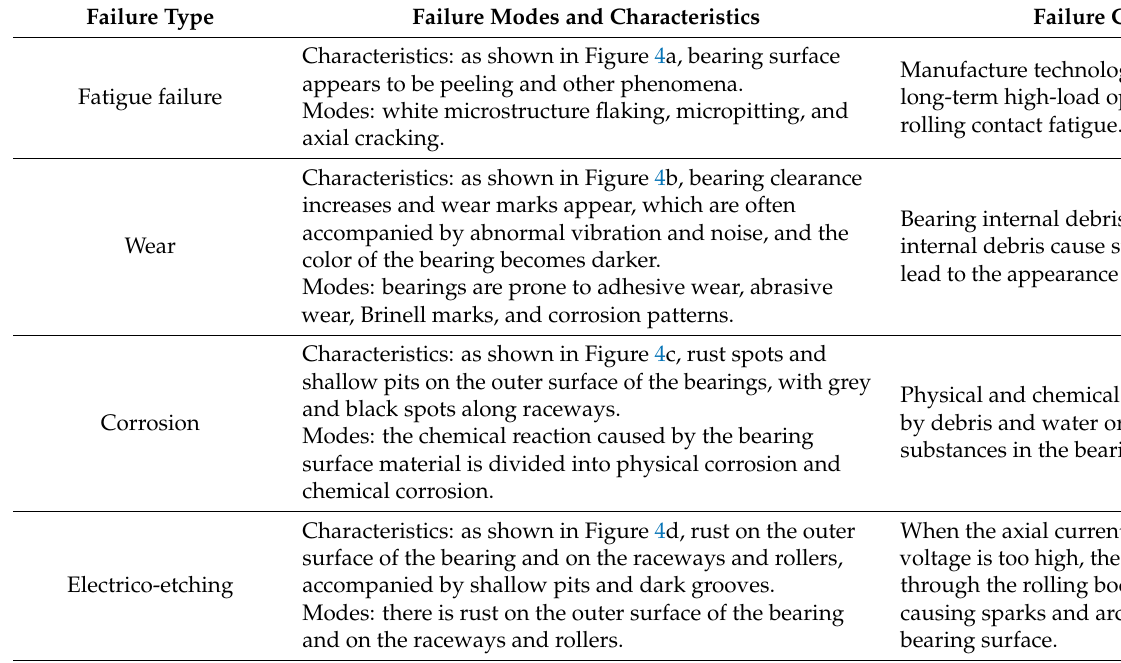
Table 3. Frictional failure analysis of wind turbine bearings (Adapted from